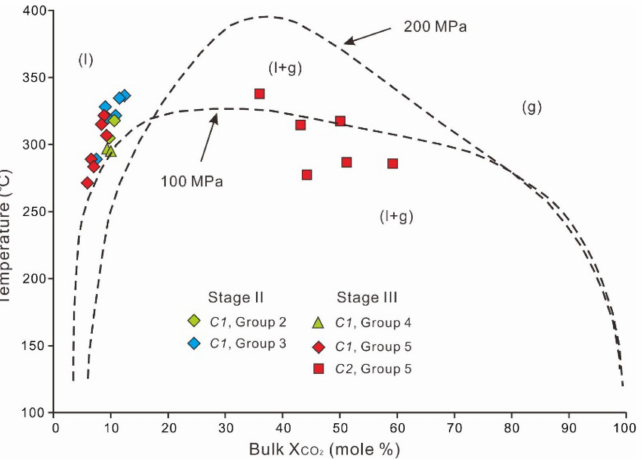
Figure 9. Homogenization temperature ( T h TOT ) versus calculated equivalent mole fraction CO 2 of type C1 and C2 inclusions in stages II and III. The dashed curves delimit the two-phase regions of the H 2 O–CO 2 –NaCl system at 100 and 200 MPa, respectively. Data after Bowers and Helgeson (1983) [30]. g, gas; l,